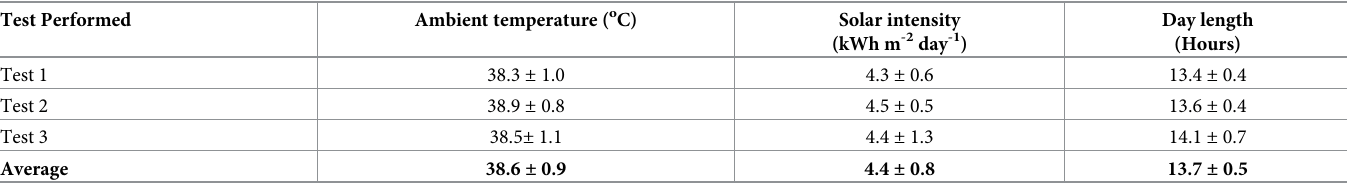
Table 2. Weather conditions during experiments on duckweed growth on leachate. Test